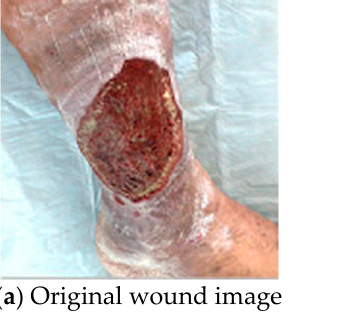
Figure 4. Original lymphovascular wound image and its explanation using heatmap.